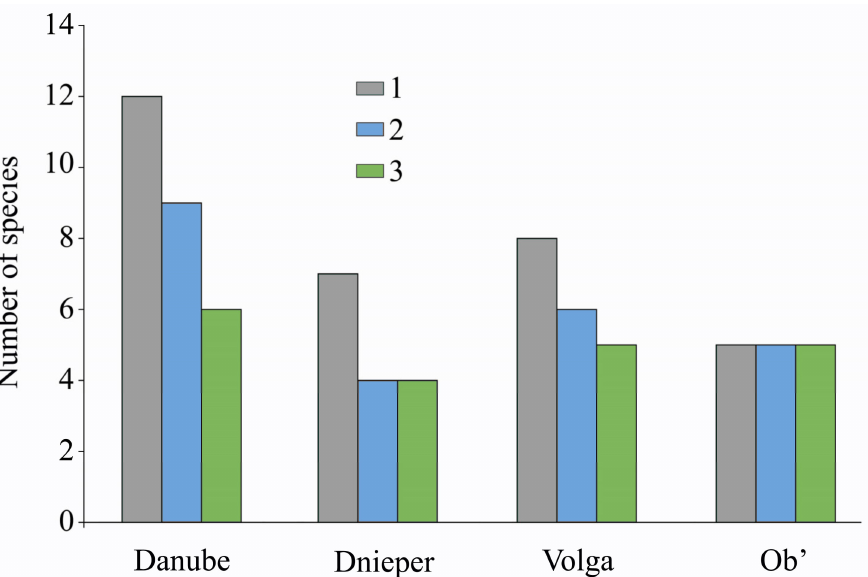
Figure 4. The significance of the intracontinental migrations of mollusks in the formation of the neobiotic malacofauna of some great river basins of Eurasia. 1—The total number of species of neobiotic mollusks registered in water bodies with the natural thermal regime; 2—The number of neobiotic mollusk species of Eurasian origin; 3—The number of neobiotic species of mollusks that inhabited this area in the Pleistocene according to paleolimnological data [72–74]. The numbers are taken from literary data surveyed during this